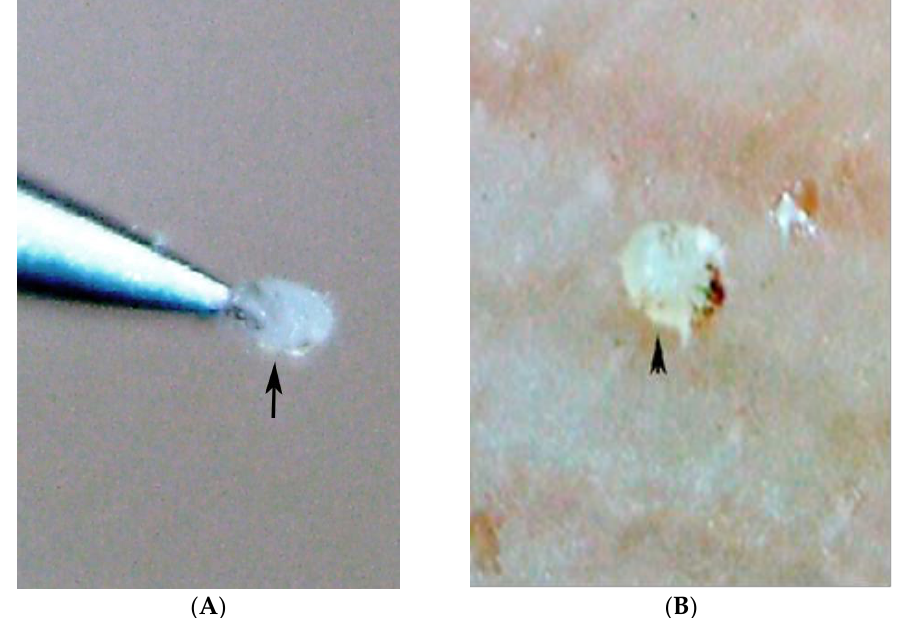
Figure 5. ( A ) Sarcoptes mite being extracted with a sterile needle by an experienced mother; magnification 70-fold. ( B ) Dorsal view of a mite extracted by the experienced mother from an acarine eminence; the hyperpigmented area of the anterior part of the mite corresponds to the delta-wing sign as seen in the dermatoscope; magnification 90-fold.